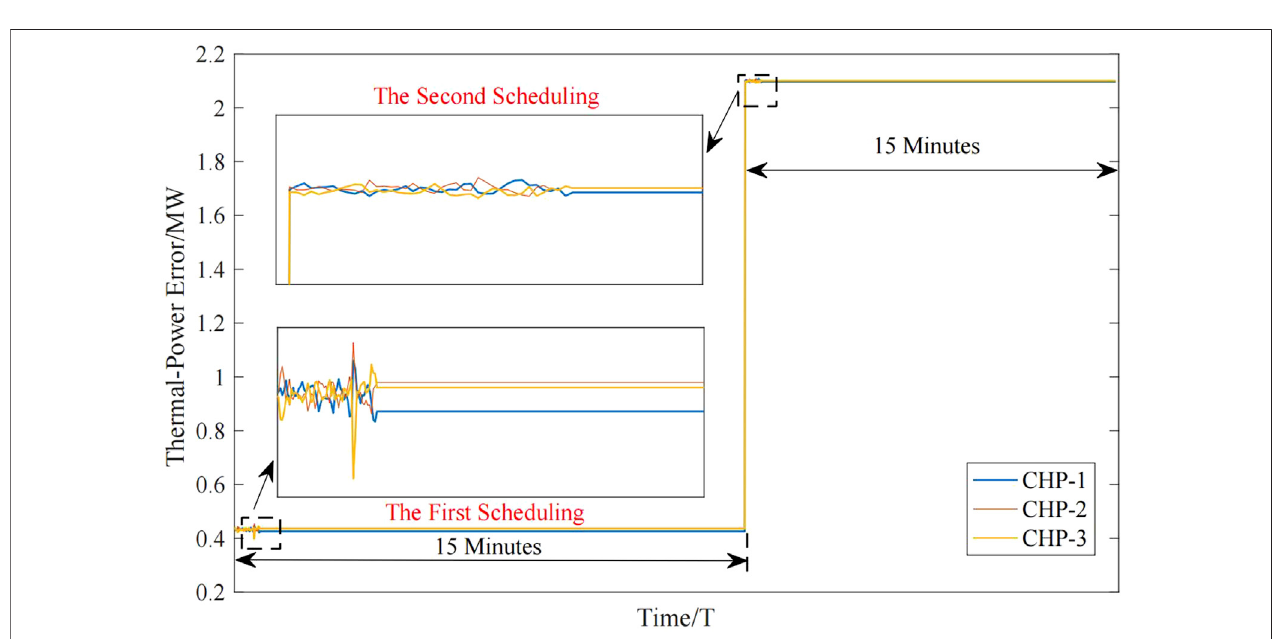
FIGURE 8 | Thermal-power outputs error on